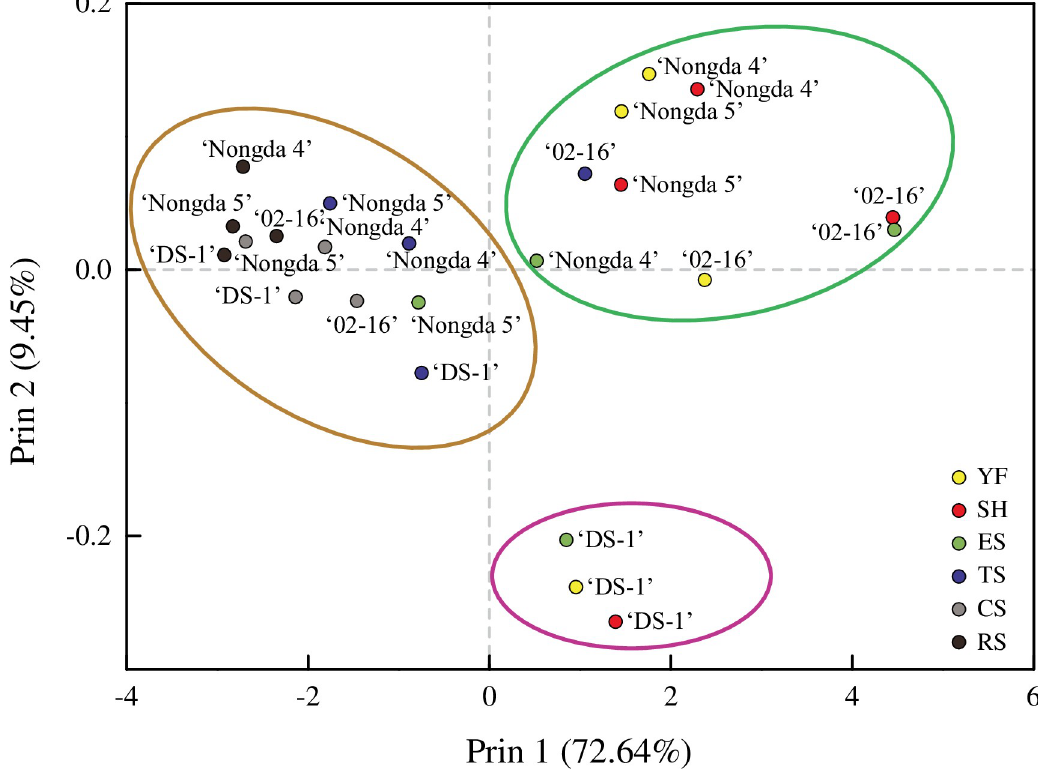
Fig 7. Scatterplot of principal component analysis based on bioactive components and antioxidant potential during fruit development of Prunus humilis . Note: YF, Young fruit stage; SH, Stone hardening stage; ES, Expension stage; TS, Turning stage; CS, Coloring stage; RS, Ripening stage. The three circles indicate the development stages belonging to the top two principal components.